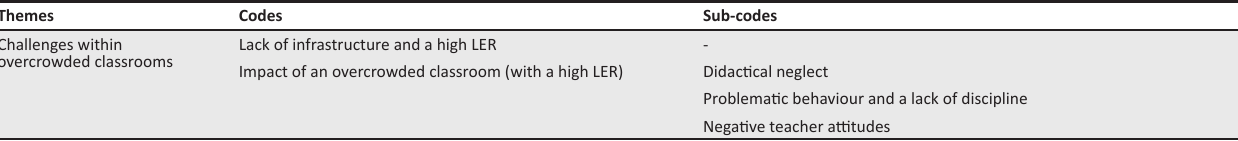
TABLE 1: Theme 1: Challenges within overcrowded